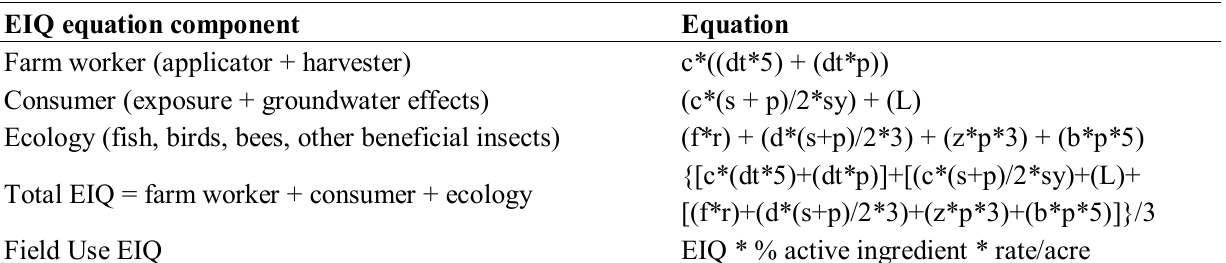
Table 5. EIQ equation environmental